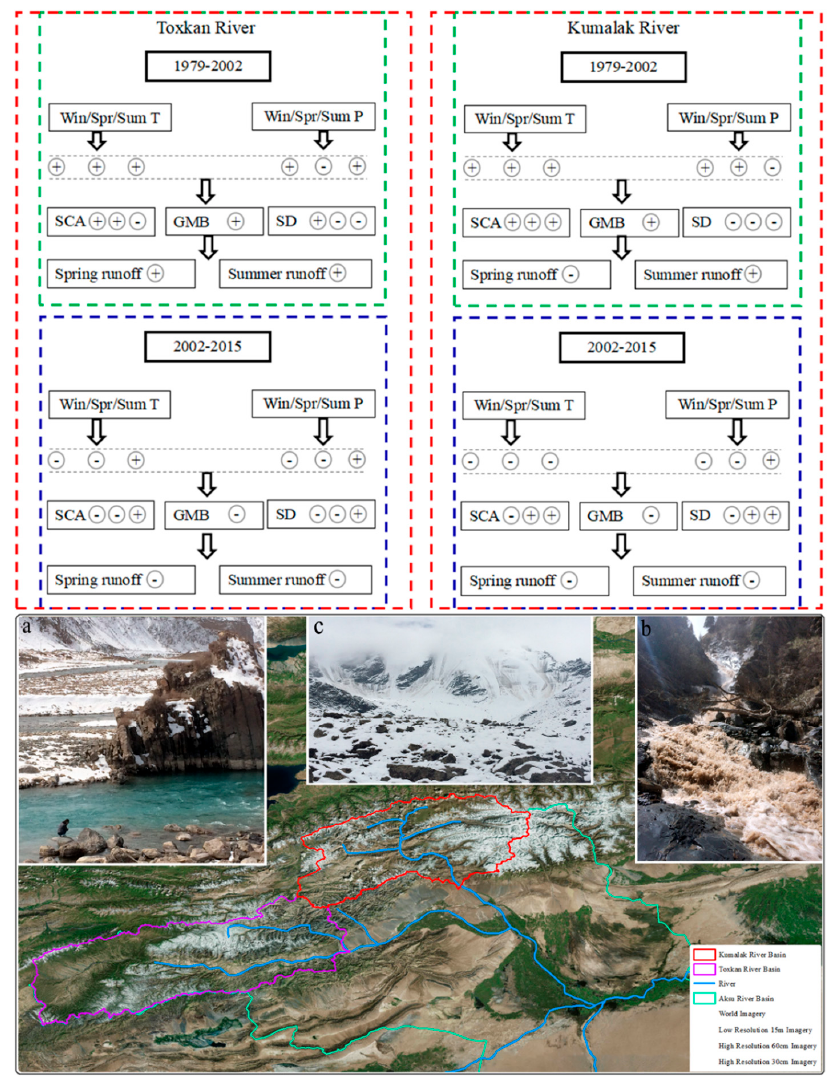
Figure 9. Schematic diagram of the combined effects of temperature, precipitation, SCA, SD, and GMB changes on Toxkan and Kumalak River runoff in the Central Tienshan Mountains during 1979–2002 and 2002–2015. ( a ) Photograph of the Toxkan River, which recharges by snow meltwater, taken on March 17, 2017; ( b ) photograph of a branch of the Kumalak River recharged by glacier and snow meltwater, taken on April 24, 2018; ( c ) photograph of glaciers covered by snow in the Central Tienshan Mountains, taken on August 17, 2016. Note: Win = Winter, Spr = Spring, Sum = Summer; the first and second symbols of ⊖ / ⊕ denote negative or positive trends, respectively.